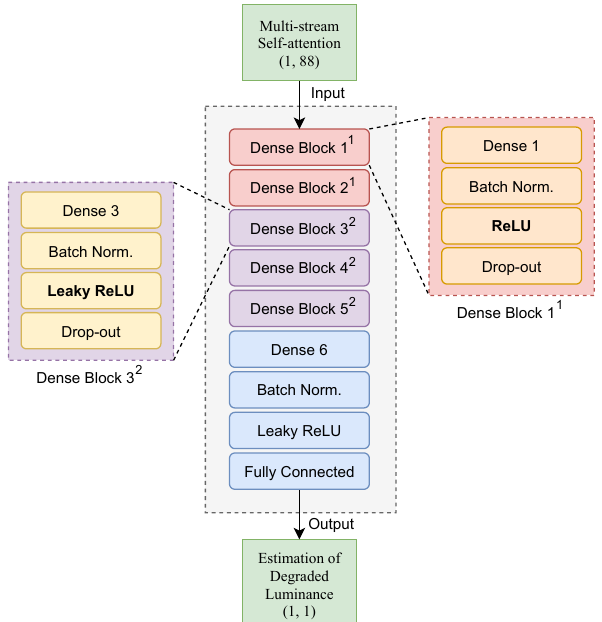
Figure 6. Overview of proposed deep-neural-network